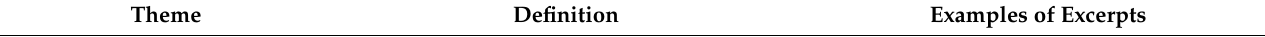
Table 3. Themes and subthemes of optimization of cancer care during the COVID-19 pandemic ( n = 235